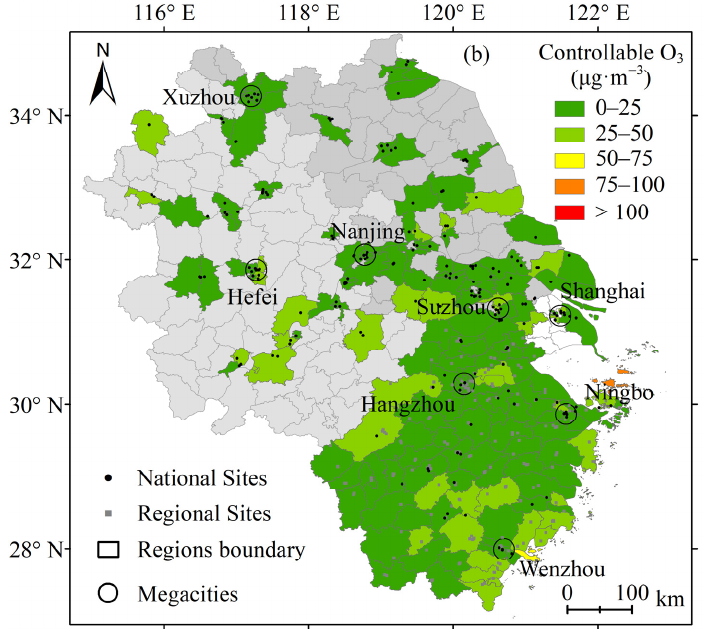
Figure 6. Controllable O 3 related to NO 2 adjustment during ( a ) April–September and ( b ) October–March in sub-county scale over the Yangtze River